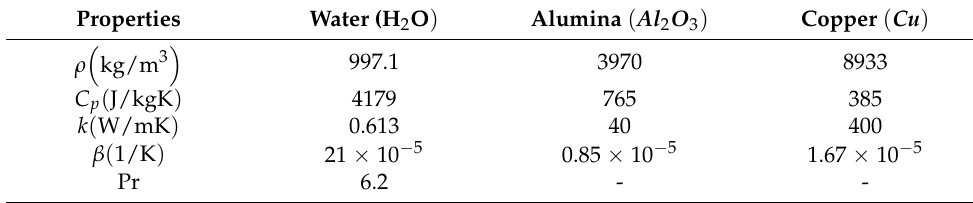
Table 2. Thermophysical properties for hybrid